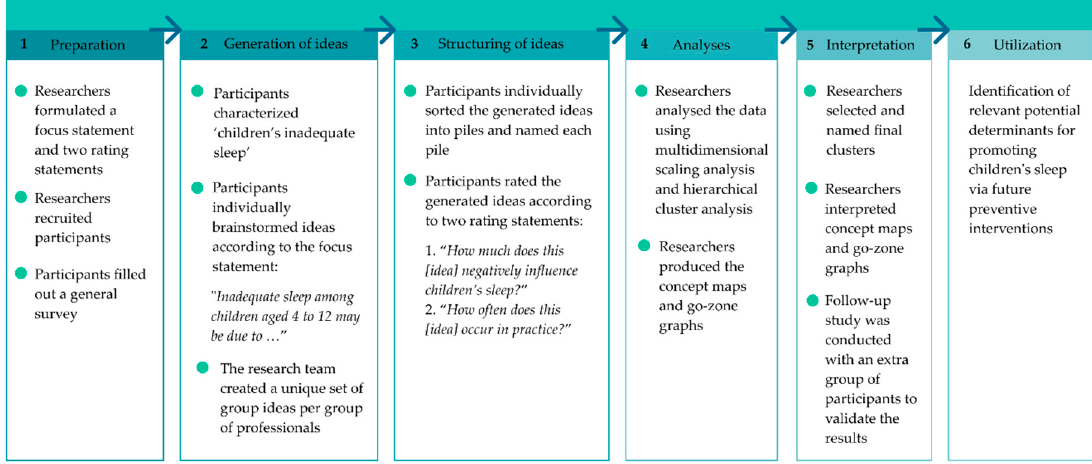
Figure 1. The six-step concept mapping process [16–18].